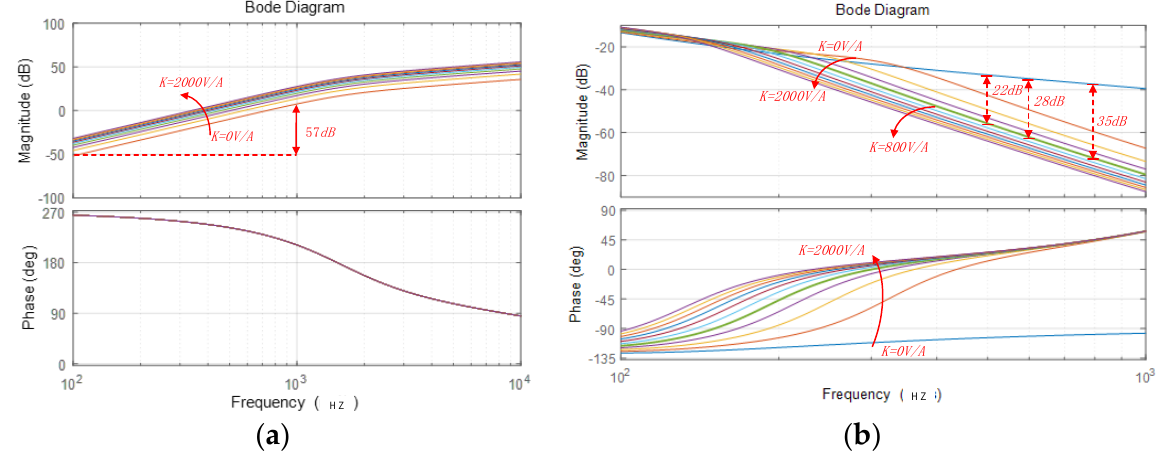
Figure 7. ( a ) Bode diagram of G D ( s ) with different control gains k ; ( b ) Bode diagram of Y ( s ) with different control gains k .